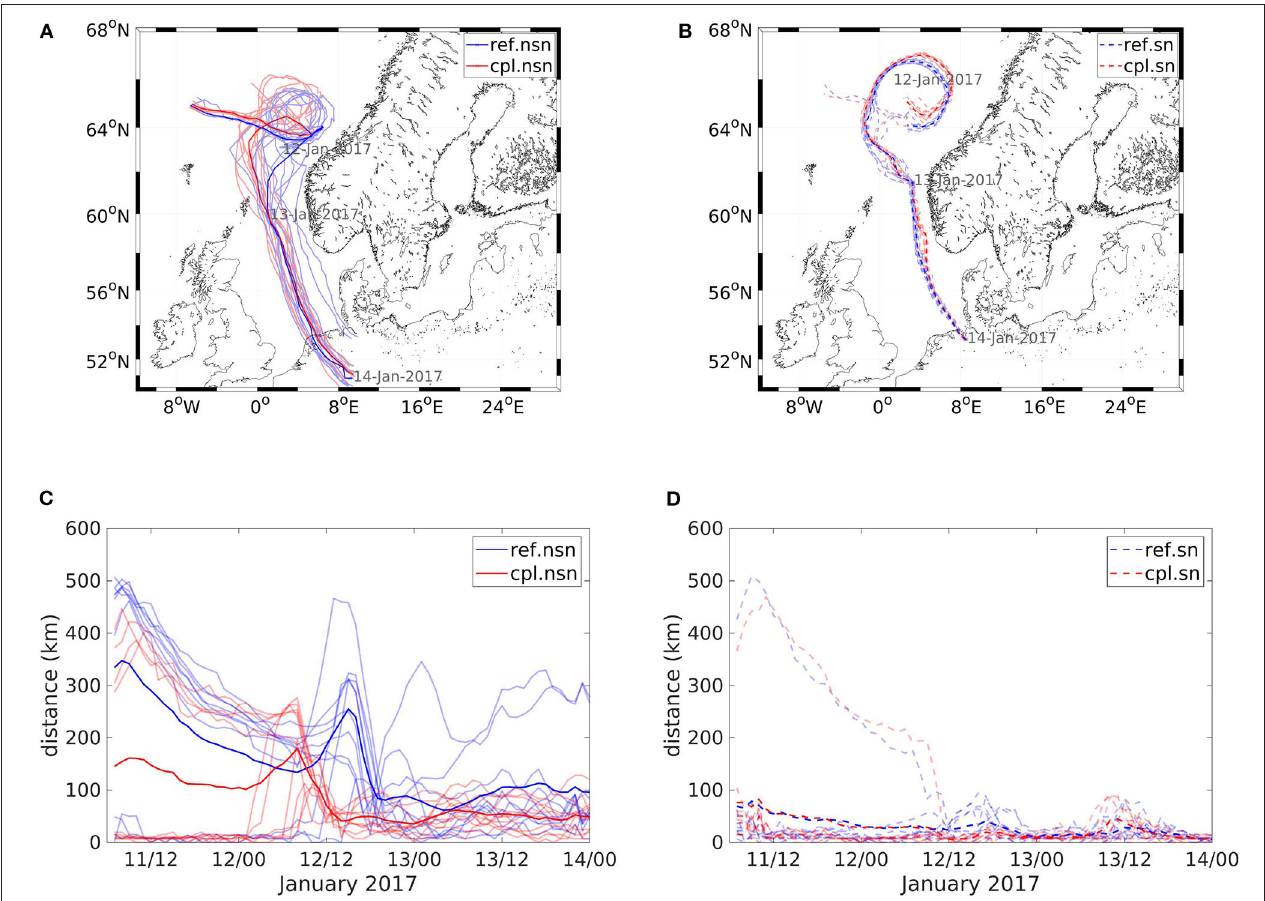
FIGURE 12 | Storm track of the secondary low from 11 January until 14 January 2017 in the simulations without (A) and with spectral nudging (B) . Light lines indicate the tracks of individual ensemble members, while the thick lines show the ensemble mean tracks. The distances from the locations of the low of individual ensemble members to the track of the ensemble mean (light lines) and the mean distances of the ensemble members to the ensemble mean (thick lines) in the simulations without (C) and with spectral nudging (D) are also